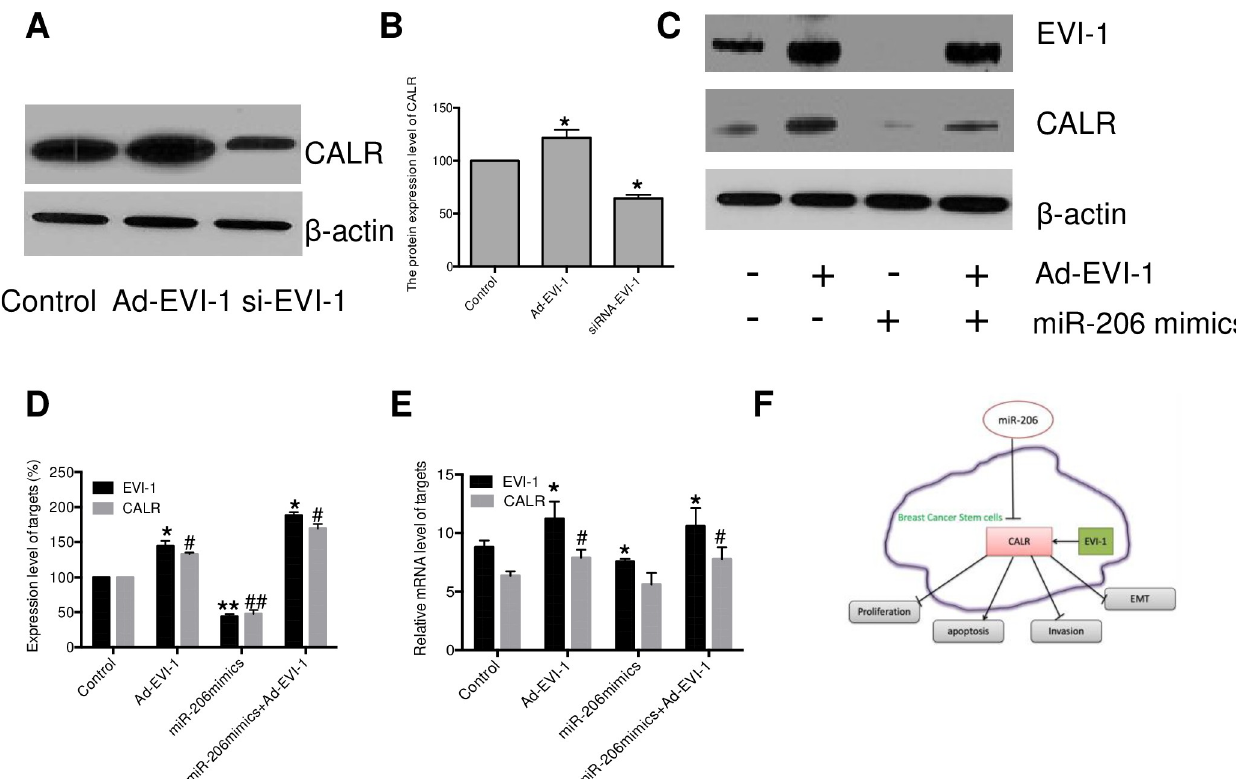
Fig 4. EVI-1 is involved in miR-206/CALR in human breast cancer stem cells. (A&B) breast cancer stem cells were transfected with Ad-EVI-1 or si-EVI-1 for 48 h, the EVI-1 expression was determined by immunoblot analysis; (C&D) Human breast stem cell were treated with miR-206 mimics, miR-206 mimics +Ad-EVI-1 and Ad-EVI-1 for 48 h. EVI-1 and CALR expression were measured by Western blotting analysis; (E), the mRNA level of EVI-1 and CALR were measured by real-time quantitative PCR; (F), Schematic of MiR/206-EVI-1/CALR pathway in human breast cancer. All results are expressed as the mean ± S. D. from three independent experiments, � P < 0 . 05 , �� P < 0 . 01; #P < 0 . 05 , ##P < 0 . 01 vs. control group.